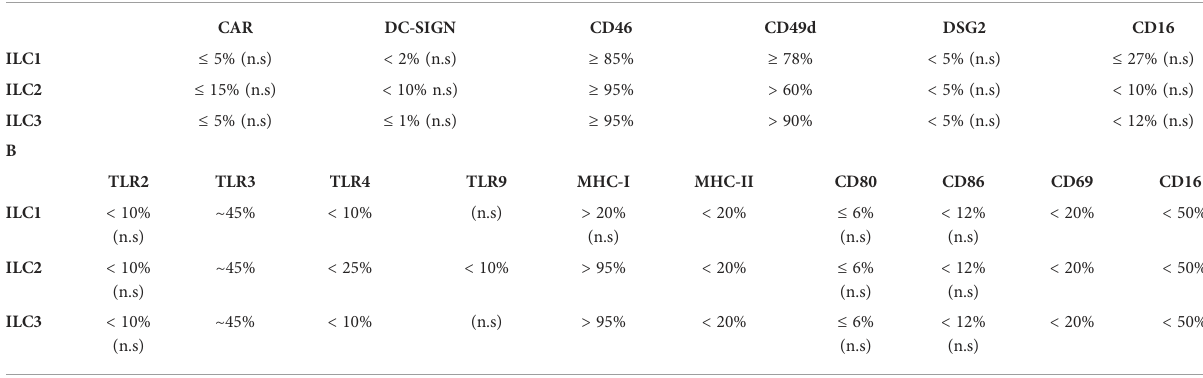
TABLE 1 Summary of the expression of (A) candidate receptors for HAdVs and (B) receptors/markers with a role in immunity by human peripheral blood